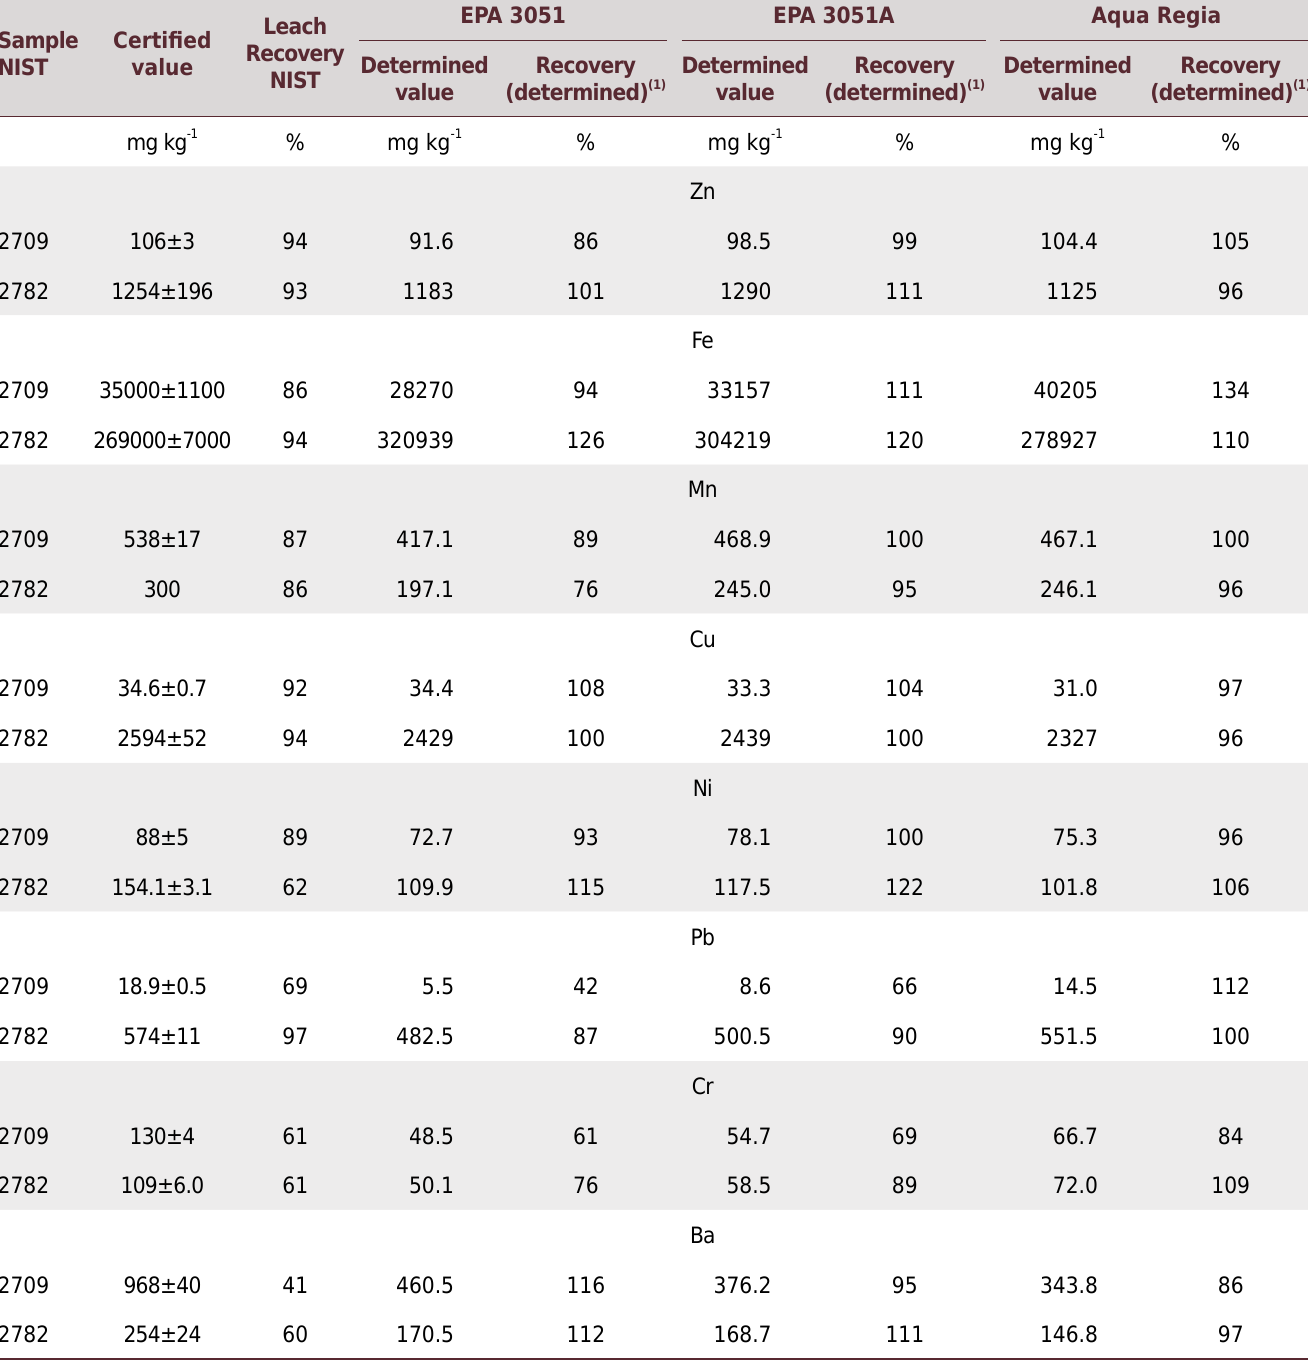
Table 3. Recovery of heavy metal in reference soils (NIST SRM 2709 and SRM 2782) by three digestion methods